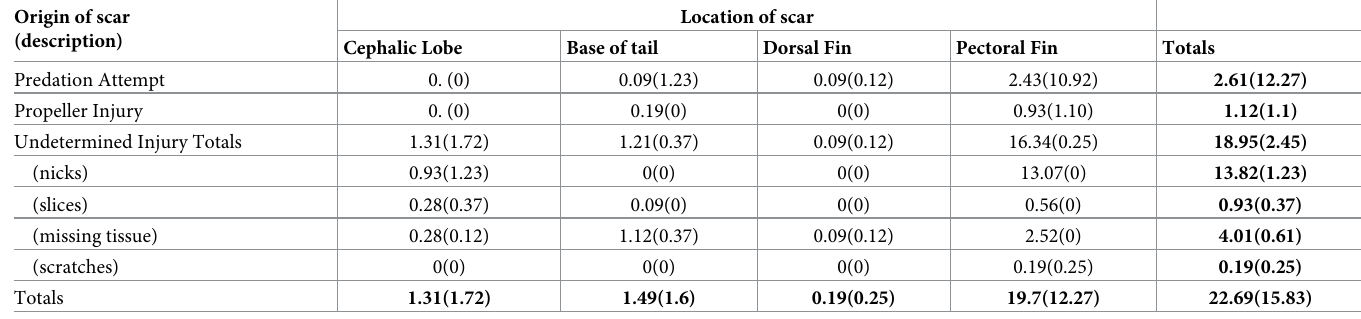
Table 1. The location and origin of scars on reef manta rays Mobula alfredi in the Ningaloo Coast World Heritage Area. Values are proportions of the images in the total photo identification database from the 1071 individual reef manta rays as of July 2018. Values in parentheses are database proportions (805 individuals) assigned prior to injury to manta ray #0018. Descriptions of wound types in parentheses refer to the scars with undetermined